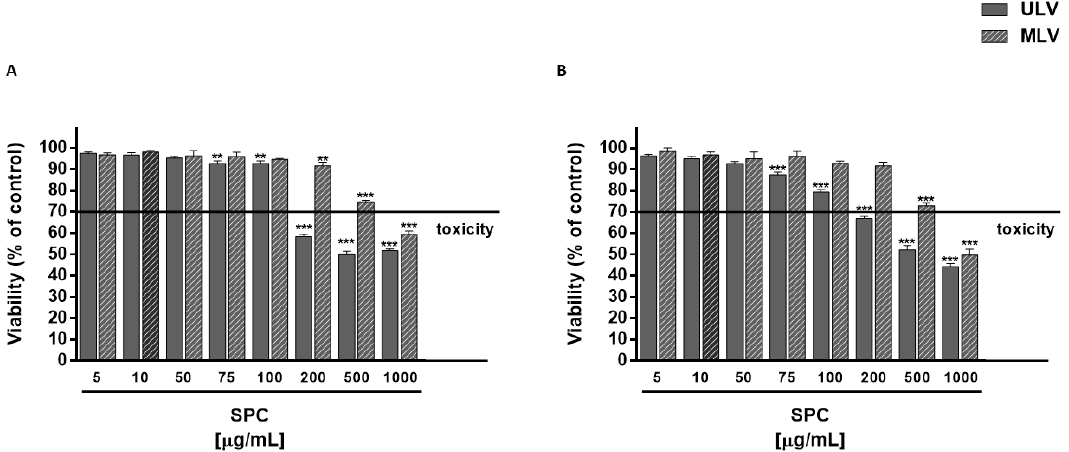
Figure 3. Effect of SPC ULV and MLV on the viability of HepG2 ( A ) and MDA-MB-468 ( B ) cells. ** p < 0.01 and *** p < 0.001 vs. control (i.e., vehicle-treated cells), denotes a statistically significant reduction of cell viability compared to control (ANOVA + multiple Dunnett’s comparison post-test). A cell viability lower than 70% respect to control was considered as cytotoxic [26].